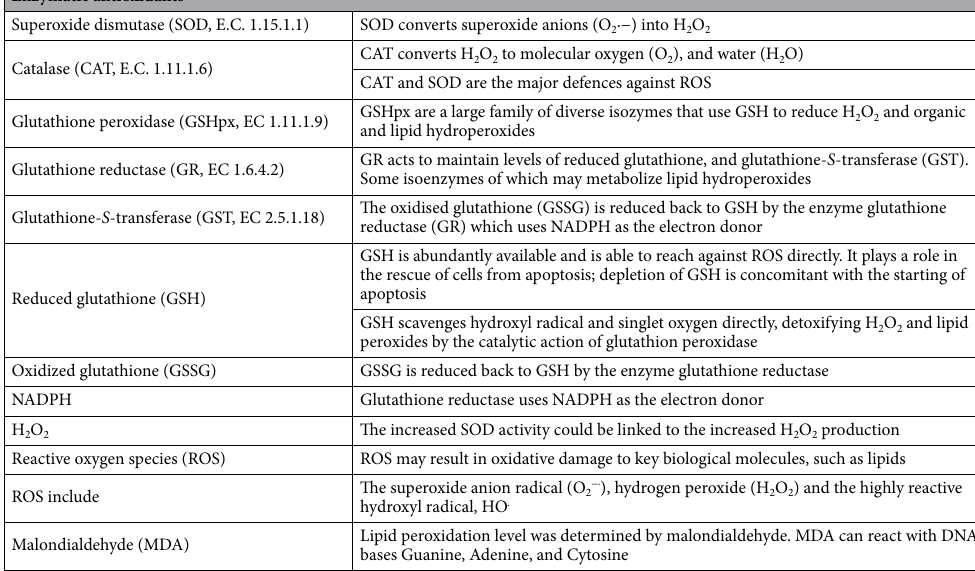
Table 2. Oxidative stress and antioxidant defence markers. The role of each enzyme studied. Enzymatic antioxidant scavenging systems that maintain endogenous reactive oxygen species (ROS) at relatively low